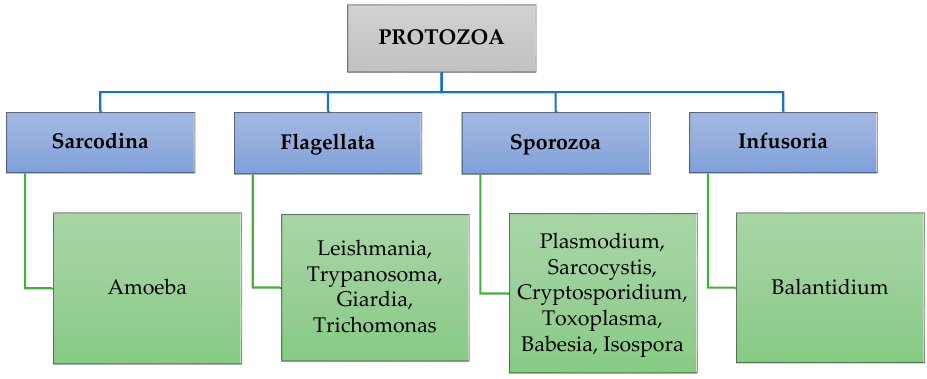
Figure 1. Classification of parasitic protozoa.